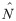
On a steepening environmental gradient, a sharp and stable range margin forms near the expansion threshold.This illustrative run shows that as the effective environmental gradient steepens away from the central location, adaptive genetic variance must increase correspondingly in order to maintain uniform adaptation. (a) Median population density stays fairly constant across the range (blue dots), following the deterministic prediction (N^, blue dashed line). Genetic variance (black dots) increases due to gene flow across the phenotypic gradient—the deterministic expectation is given by the grey dashed line (see Model section of Methods for details). Yet, as the environmental gradient steepens, genetic variance fails to increase fast enough, and near the expansion threshold, adaptation fails. The dotted line gives the corresponding critical genetic variance, below which only limited adaptation is expected in a phenotypic model with a fixed genetic variance (A≈B2/2, in which A is the standing genetic load; [24]). (b) As the environmental gradient steepens, the frequency of limited adaptation within the metapopulation increases (black and grey), and hence neutral variation decreases (blue). The black line gives the proportion of demes with limited adaptation after 50,000 generations, when the range margin appears stable; grey gives the proportion after 40,000 generations (depicted is an average over a sliding window of 15 demes). The median is given over the neutral spatial axis Y (with constant optimum); the trait mean, the population trait mean, variance, and population density in two-dimensional space is shown in S3 Fig, which also lists all the parameters.